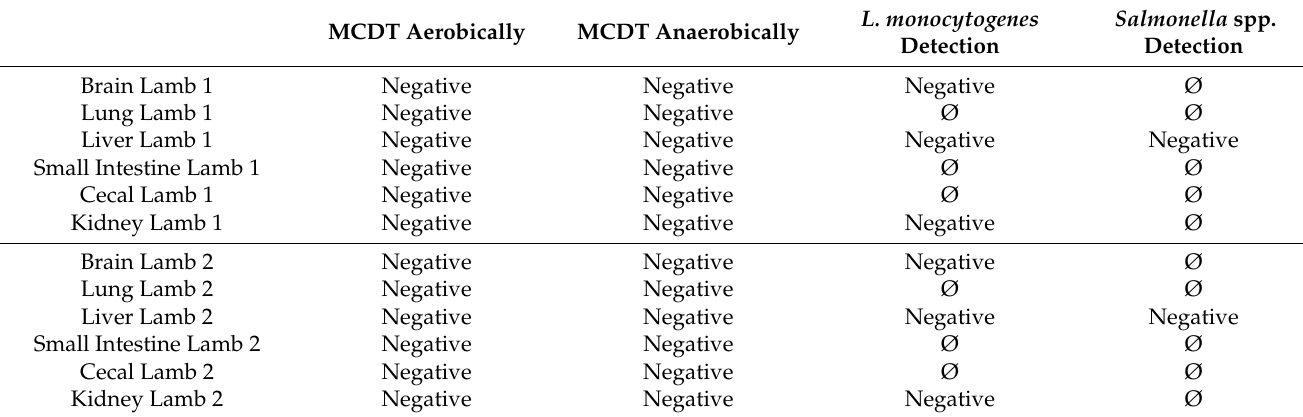
Table 2. Results of microbiological culture-dependent testing on two lambs. Ø = Not Tested.